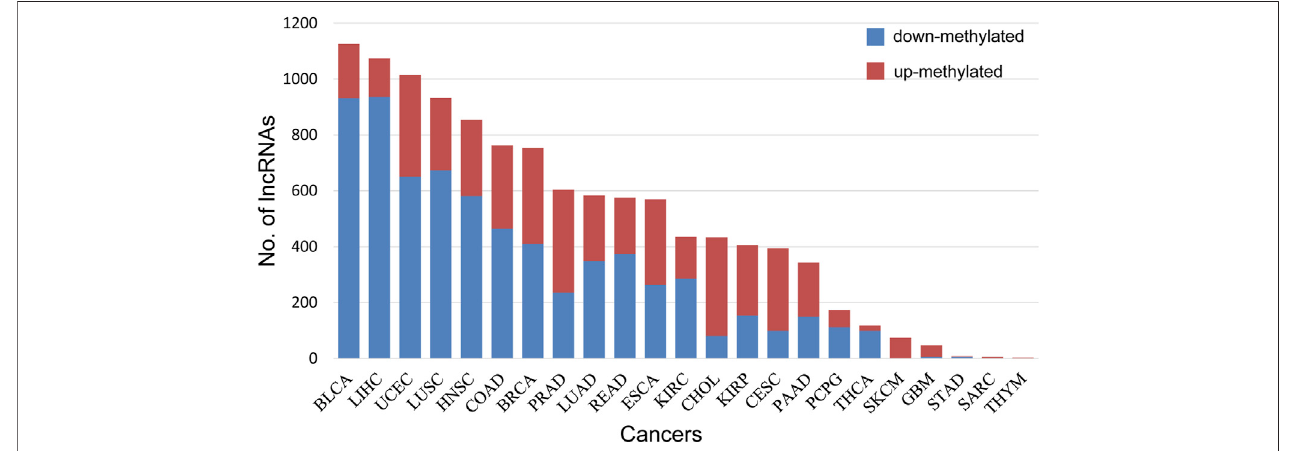
FIGURE3| Thepercentage ofup-methylatedanddown-methylatedlncRNAsforeachcancer.Bluerepresentsthenumberofdown-methylated lncRNAs,andred represents the number of up-methylated lncRNAs.